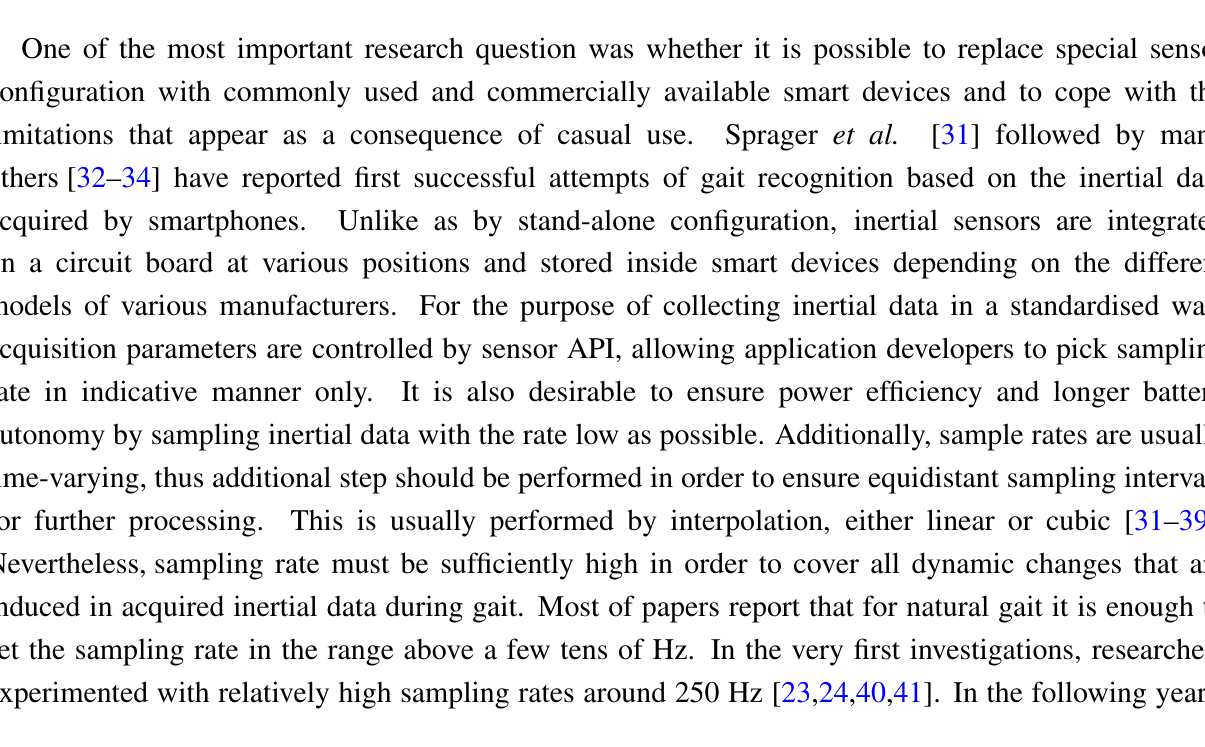
Figure 2. Methodological layout of existing inertial sensor-based gait recognition